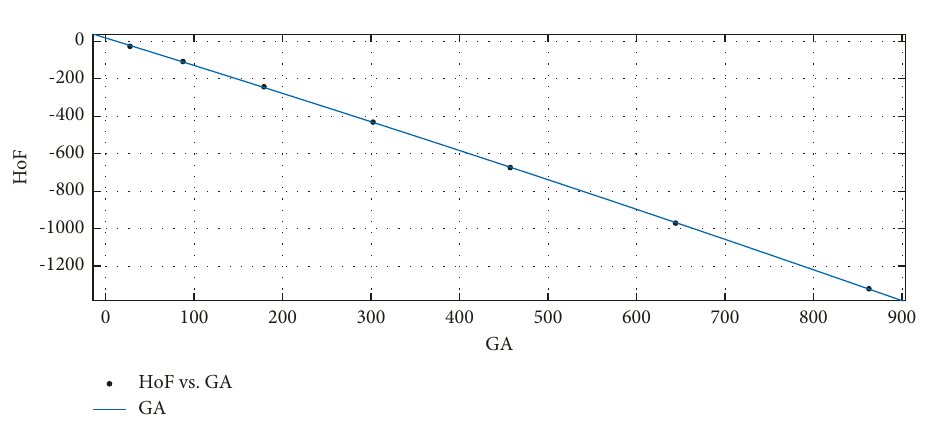
Figure 7: ABC vs. HoF.